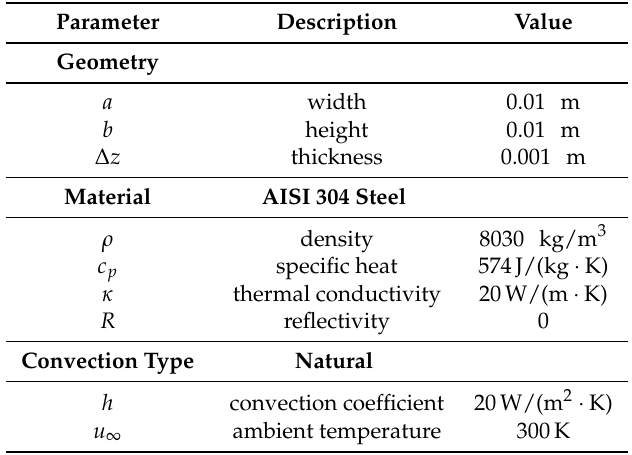
Table 1. Sheet heat transfer parameters for the simulations (same as in [14,31,35]).